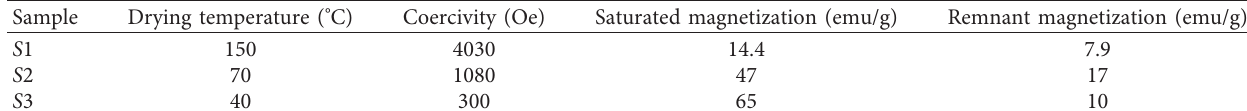
Table 4: The magnetic properties of samples S 1, S 2, and S 3.